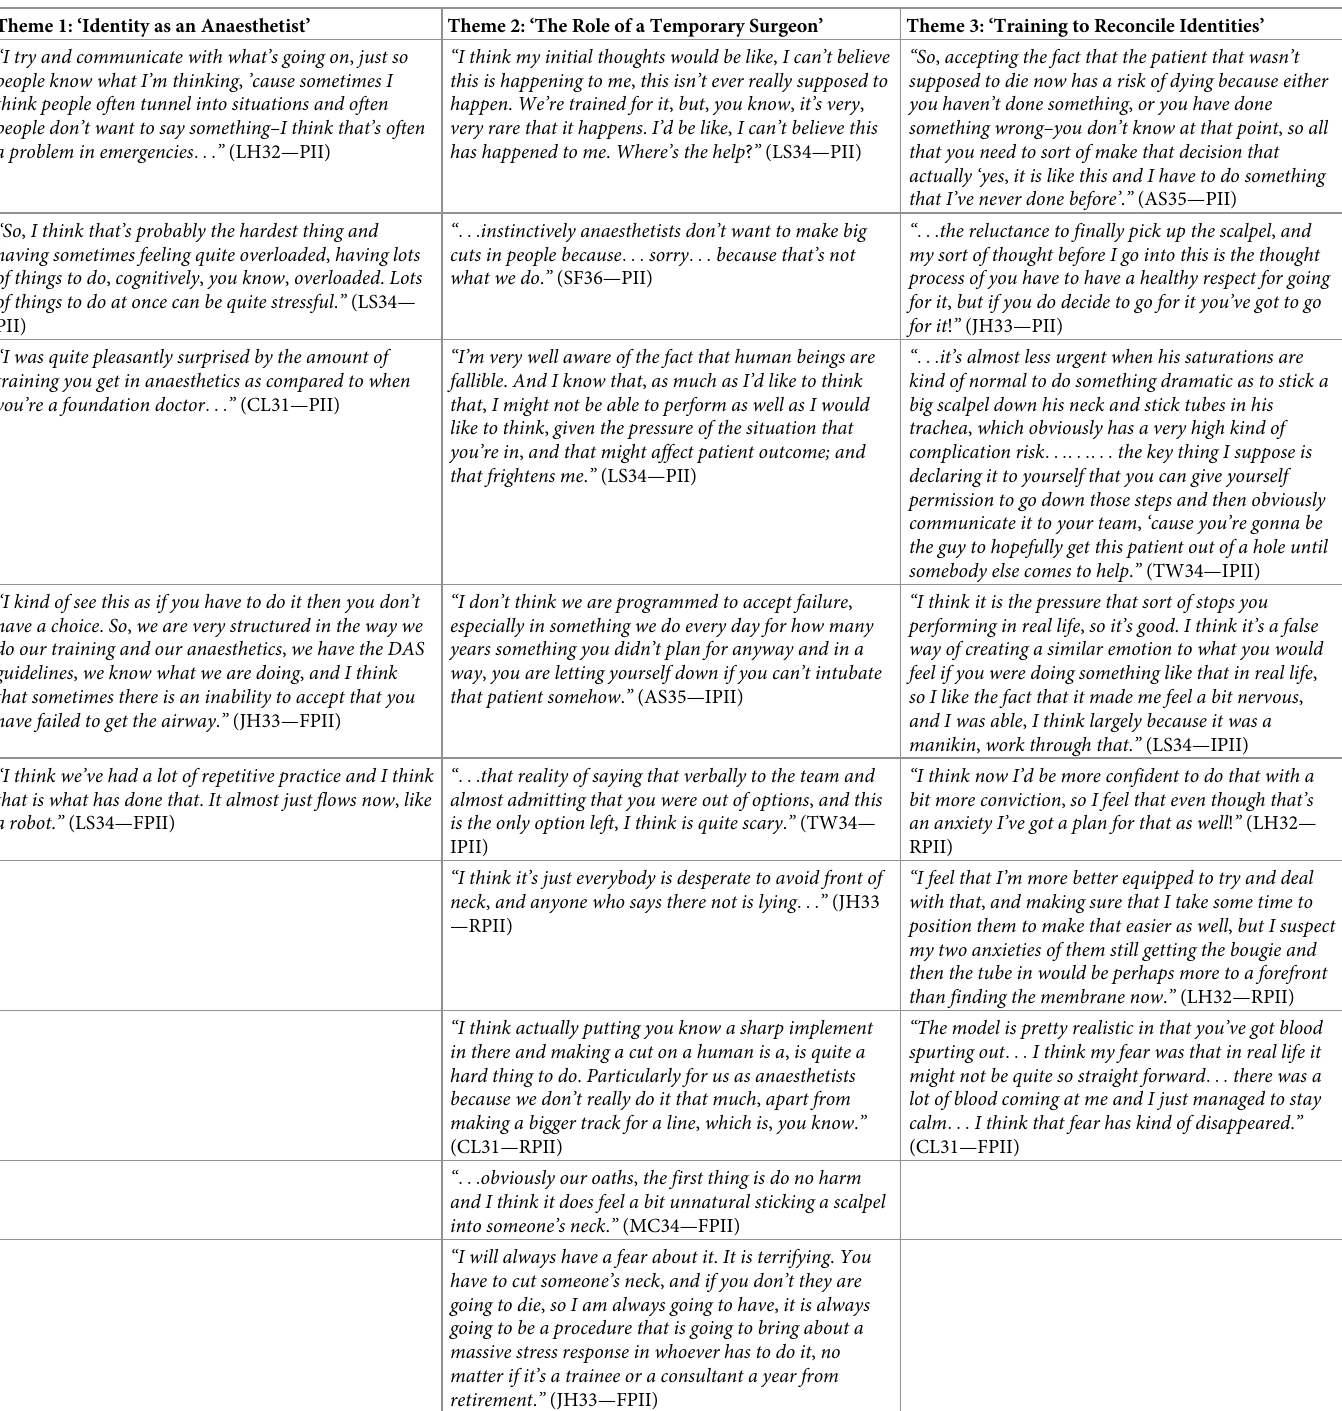
Table 2. Supplementary